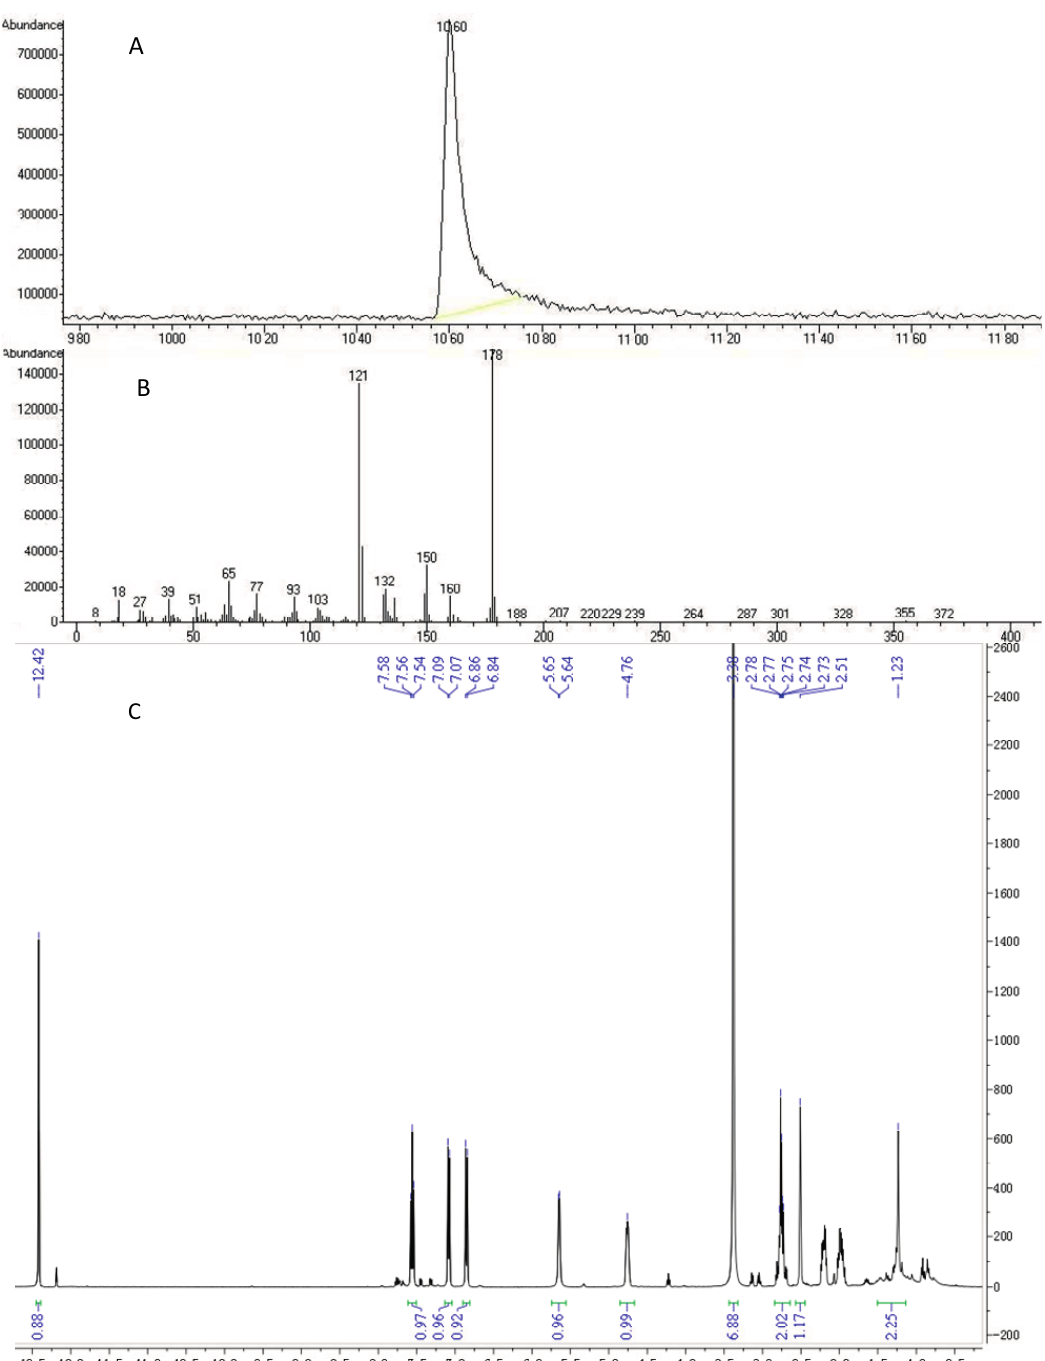
Figure 4. Structure identification of 4,8-DHT: ( A ) and ( B ) GC-MS spectra; ( C ) 1 H-NMR spectra; ( D ) 13 C-NMR